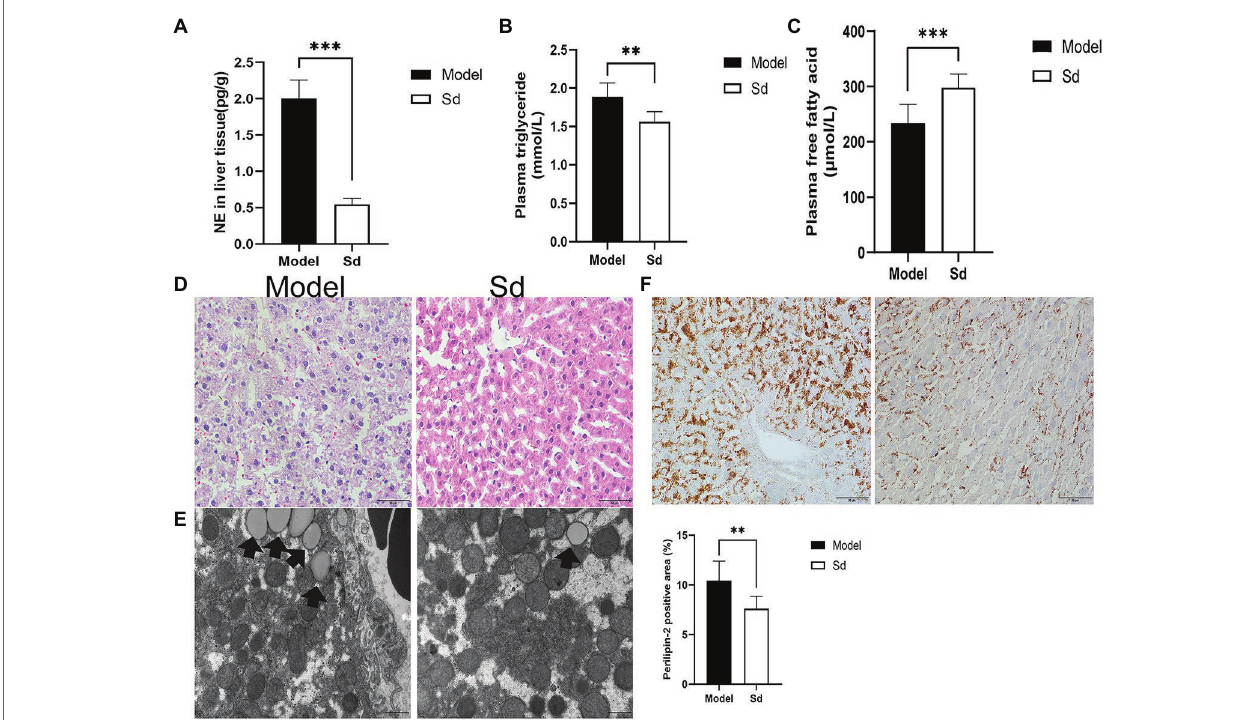
FIGURE 5 | The effect of sympathetic denervation on hepatic steatosis. (A) NE of sympathetic neuromediators in liver was detected. (B) The plasma triglyceride levels in the liver tissues were analyzed. (C) The plasma free fatty acid levels were detected. (D) HE staining (scale bar: 50 μ m). (E) TEM was performed to observe lipid droplets (scale bar: 1 μ m). (F) Quantitative analysis of lipid droplets was measured by Perilipin-2 immunohistochemistry (scale bar: 50 μ m). The results were obtained from two independent experiments and are expressed as the mean ± SD, n = 8 per group, ** p < 0.01; and *** p < 0.001. Sd, sympathetic denervation group; NE,